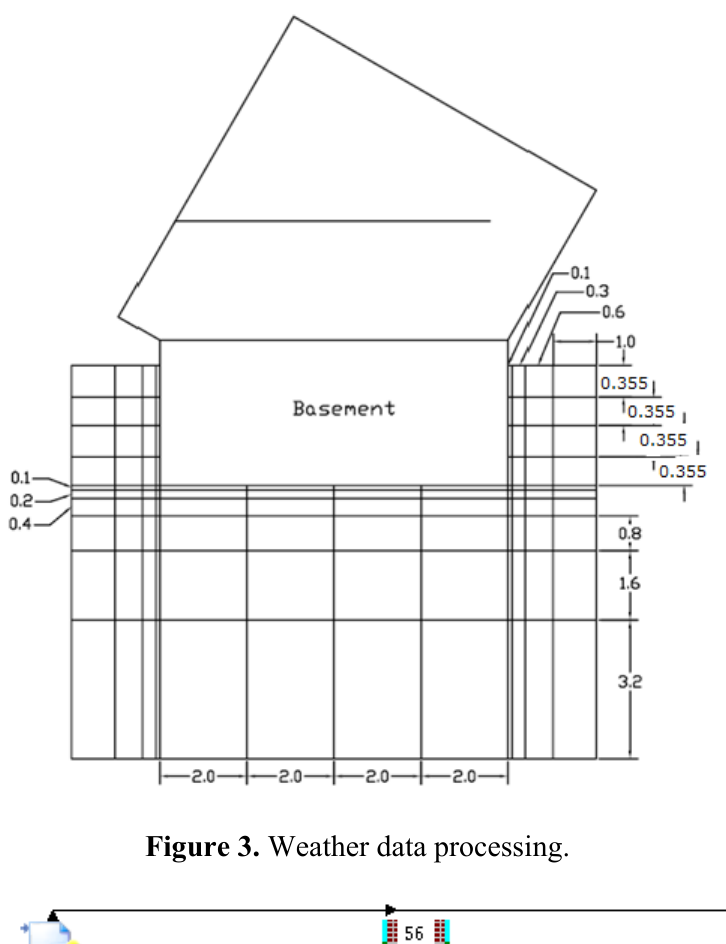
Figure 2. Near-field soil grid geometry (dimensions are in meters).